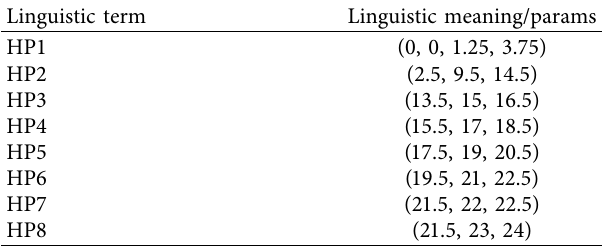
Table 3: High PEEP linguistic terms used. Linguistic term